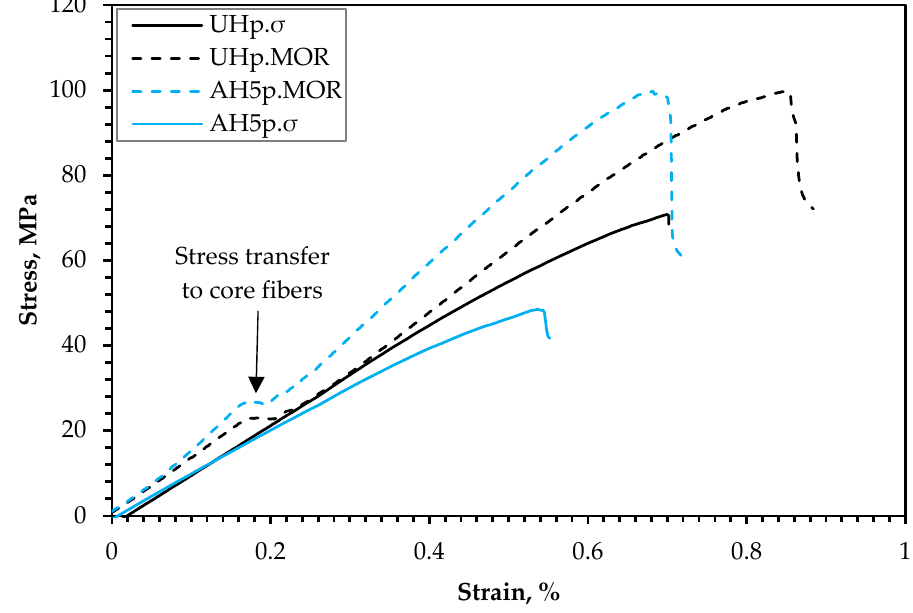
Figure 11. Stress ( σ (–)];[MOR (- -))–strain curves of UHp and AHp. Comparing the σ result based on the introduction of alkali treatment, UHp and AH5p show a reduction of 14% and 42%, respectively, compared to the non-FR variants (UH and AH5). Despite the higher flexural performance for AH5p compared to UHp, the decrease in MOR relative to AH5 was considerably higher (8%) than for UHp compared to UH (6%). The results from Sections 3.3.1 and 3.3.2 demonstrate that reinforcing PLA with